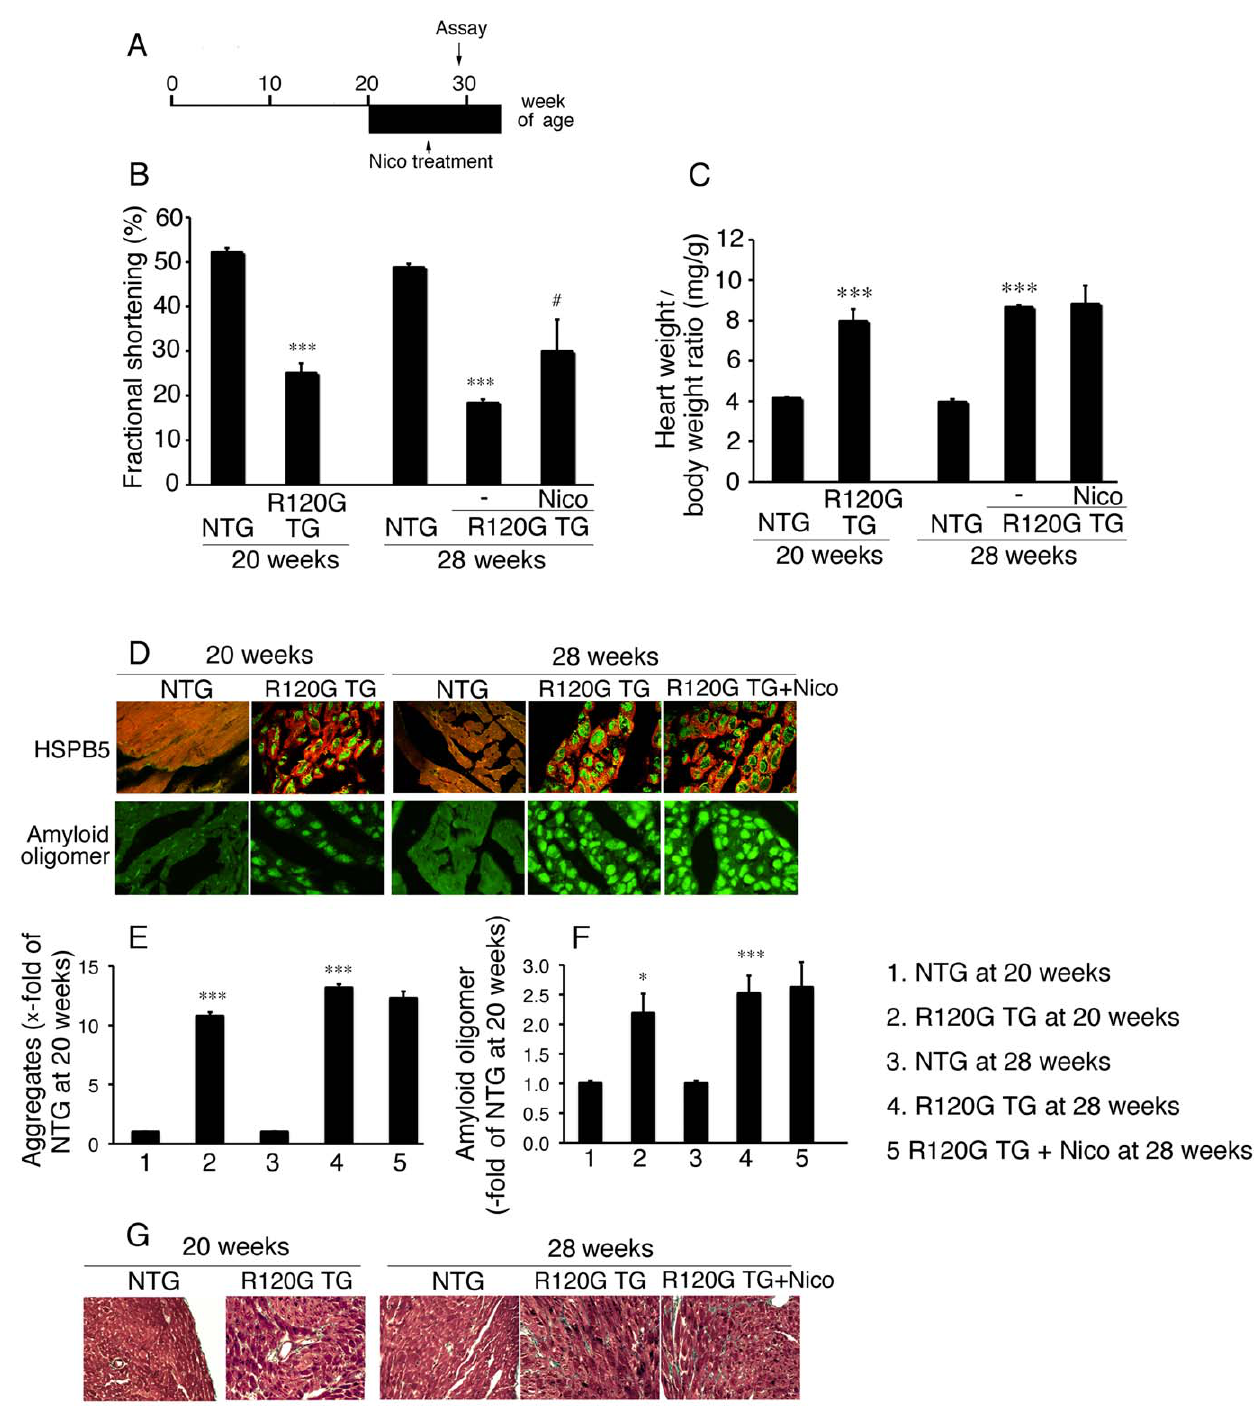
Figure 6. Effect of Nico (81 mg/l of drinking water) on cardiac disease at late stage in the HSPB5 R120G (R120G) TG mice. (A) Protocol was shown. Nico was administered via drinking water from 20 weeks of age in the R120G TG mice. (B) Fractional shortening assessed by the echocardiogram. Cardiac functional measurements were made at 28 weeks (n=6–10 mice). (C) The ratios of heart weight/body weight. (n=6–10). (D) Representative pictures of the immunohistochemistry are shown. The aggregates containing the mutant R120G protein (upper panel green) and amyloid oligomer (lower panel green) were observed in the R120G TG mice. To distinguish between the cardiomyocytes, cardiac troponin I was stained (upper panel red) (E and F) Quantitative analysis of the aggregates containing the mutant HSPB5 R120G protein (E) and amyloid oligomer (F). (n=4). (G) Masson’s trichrome stain in the R120G TG mouse heart with or without Nico treatment. * p , 0.05, *** p , 0.001 vs. non-transgenic (NTG) mice; # p , 0.05, ### p , 0.001 vs. R120G TG mice.